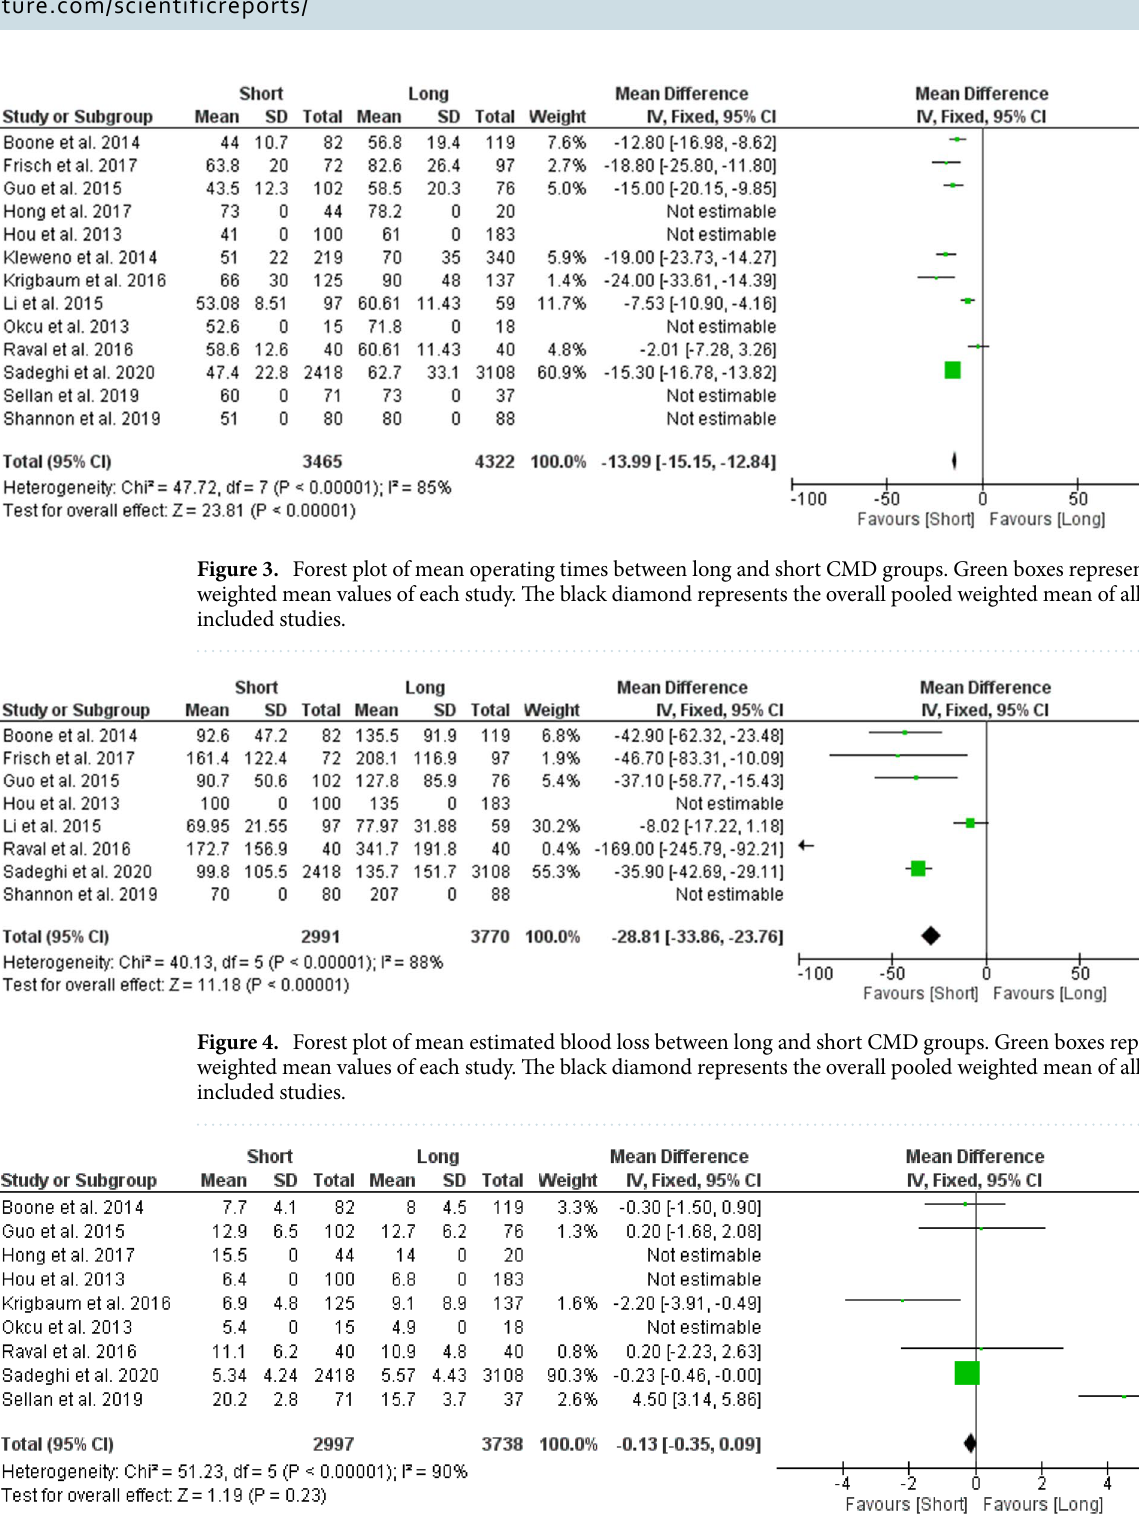
Figure 5. Forest plot of mean length of stay between long and short CMD groups. Green boxes represent weighted mean values of each study. The black diamond represents the overall pooled weighted mean of all included